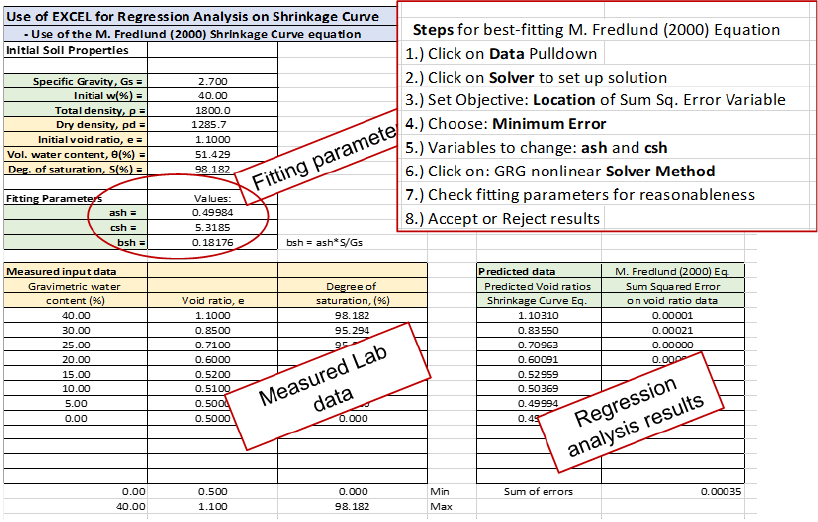
Figure 5. Use of a micrometer to measure the volume at various degrees of drying.